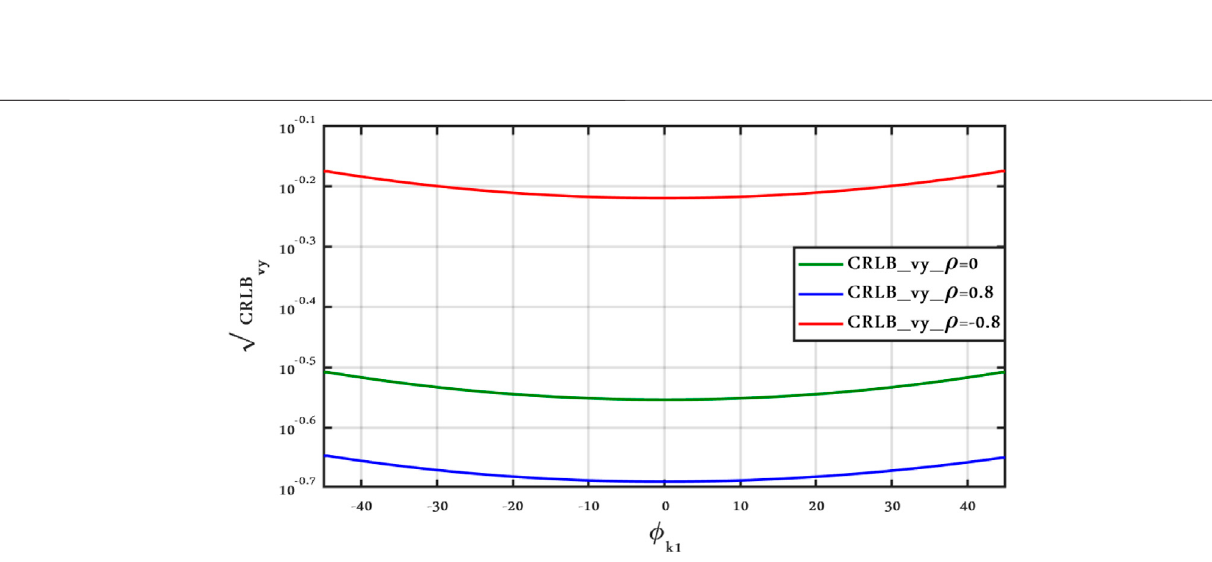
FIGURE 14 | CRLB vy vs. ϕ k 1 antenna position, Clutter Model II for different ρ with ] = 2.1, SCR = 0 dB , and v x = v y = 50 m/s.